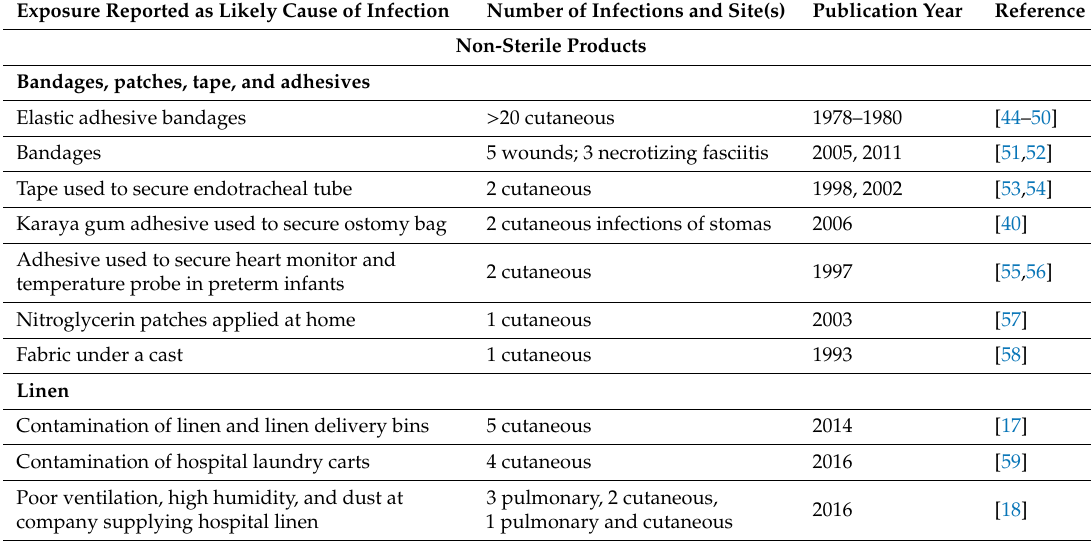
Table 2. Attributed or suspected healthcare exposures in published reports of mucormycosis. Exposure Reported as Likely Cause of